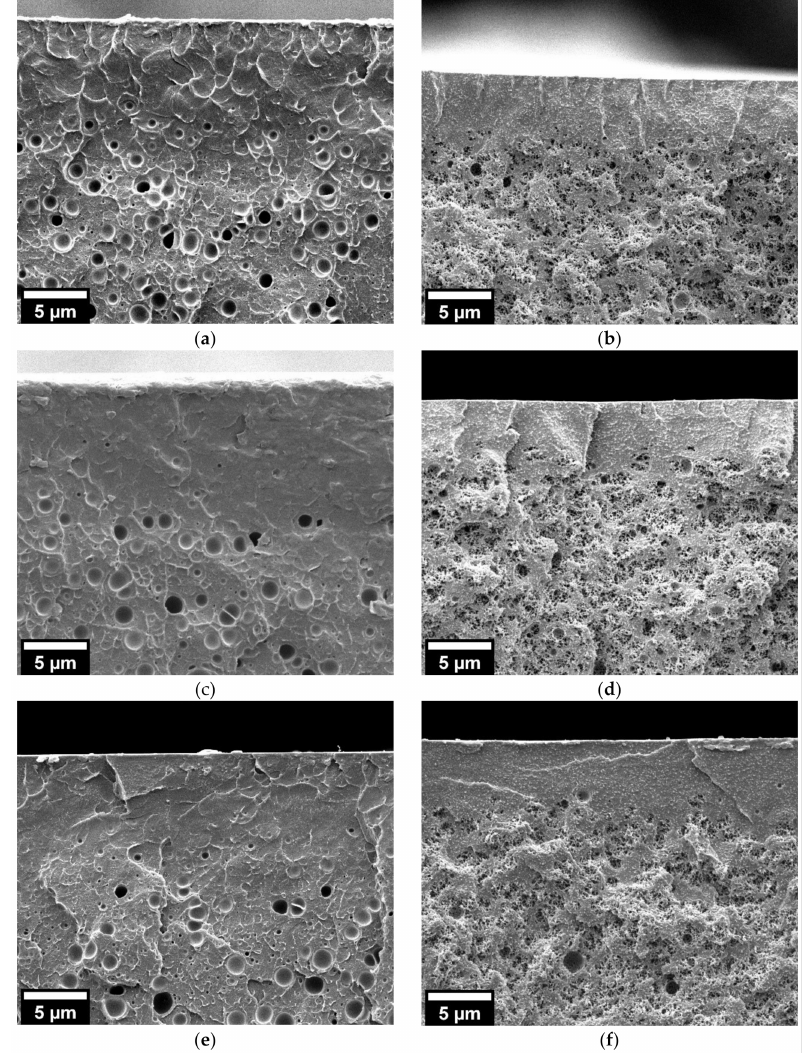
Figure 6. HRSEM micrographs of the solid outer layer of neat PMMA (left) and 25/75 PMMA/MAM (right) foams obtained from films at saturation pressure and temperature of 30 MPa and 50 ◦ C, respectively, and a post-foaming procedure carried out for 1 min at different temperatures ( a , b ) 40 ◦ C; ( c , d ) 60 ◦ C; ( e , f ) 80 ◦